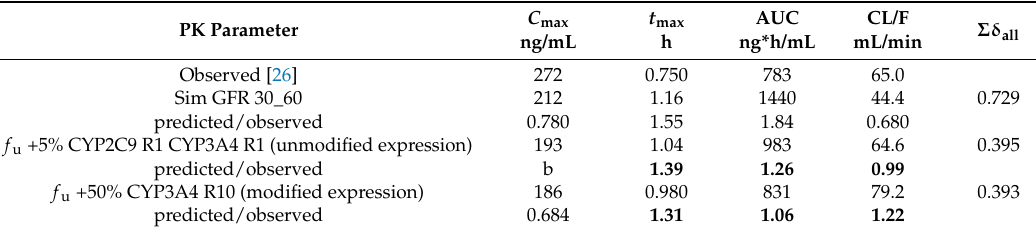
Table 2. Comparison of Predicted and Observed Values for Pharmacokinetic Parameters for Sildenafil in Moderately Renally Impaired